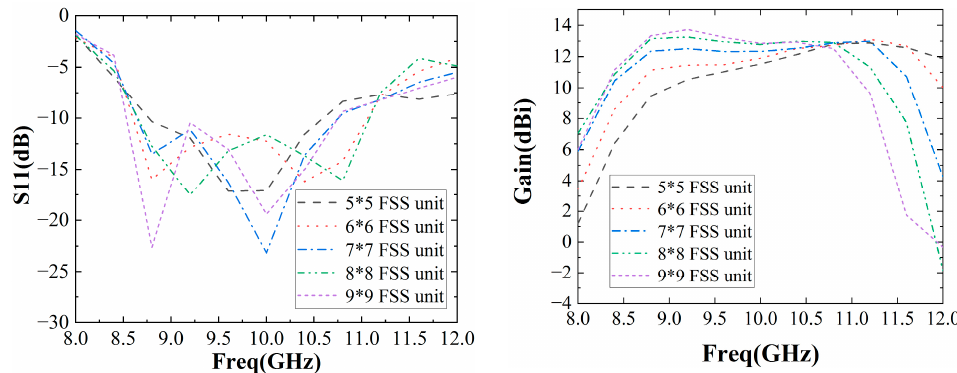
Figure 13. Simulation of F-P antenna S11 and gain as a function of number of FSS unit cells.